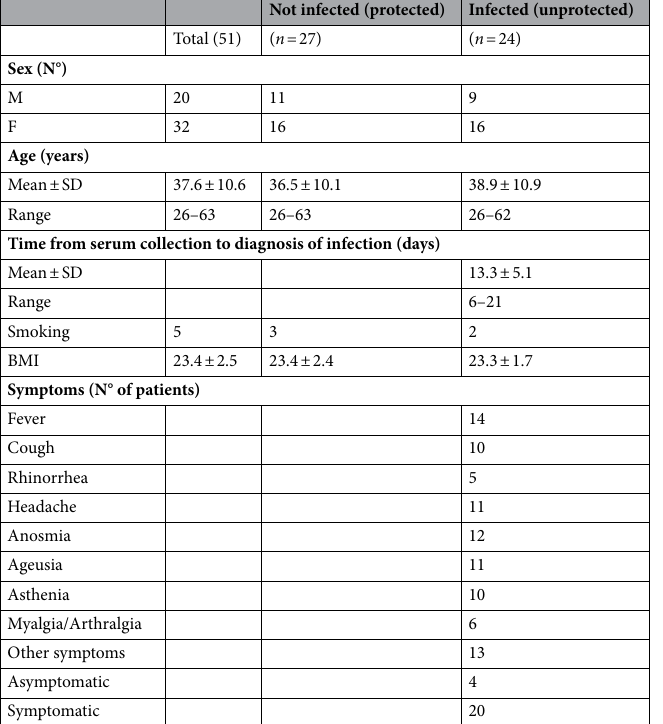
Table 2. Characteristics of the subjects included in the